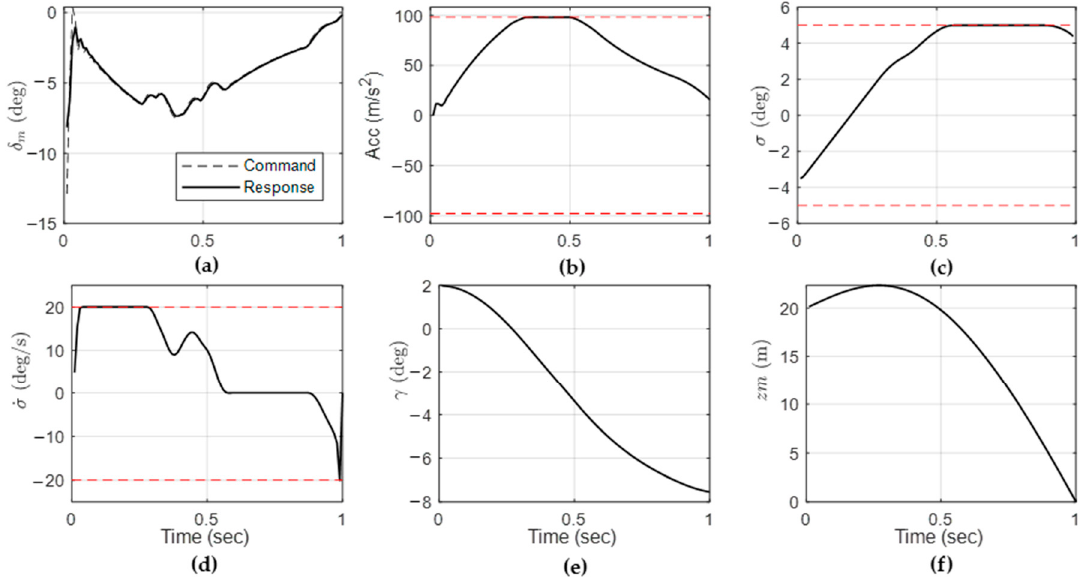
Figure 4. ( a ) actuator command and response; ( b ) acceleration of missile; ( c ) seeker look angle; ( d ) look-angle rate; ( e ) flight path angle; and ( f ) relative displacement between the target and the missile.